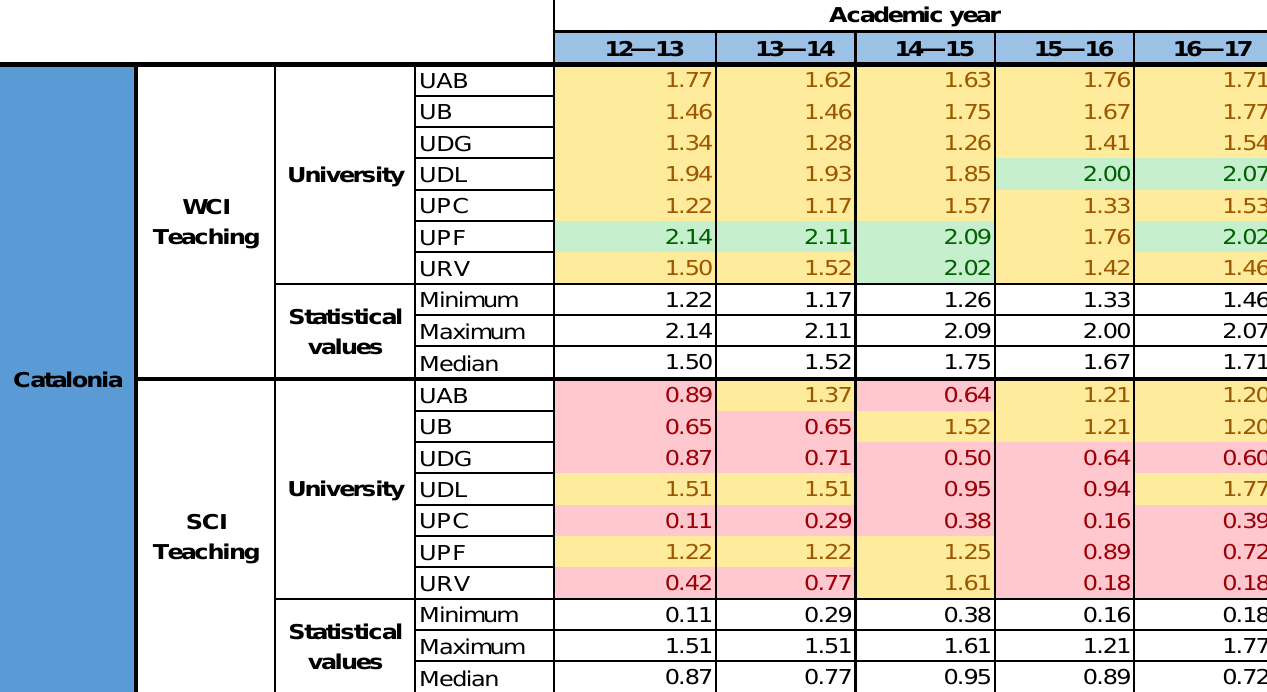
Figure A6. WCI and SCI values of the Andalusian public universities in their teaching mission.